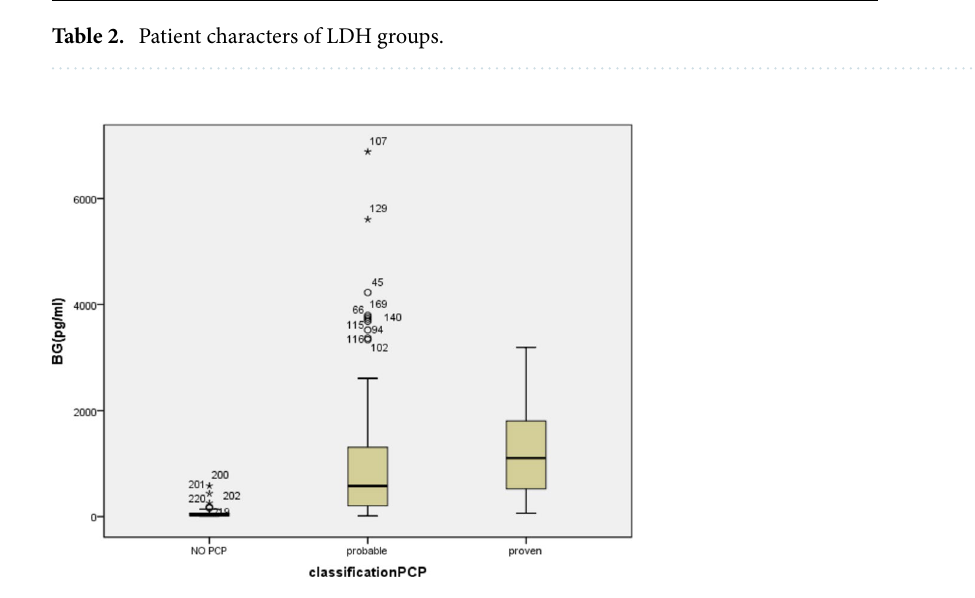
Figure 2. (Box-and-whisker plot): The mean levels of BG in patients with no PCP, probable PCP and proven PCP were 65.03 pg/mL, 983.22 pg/mL, and 1220.09 pg/mL, respectively. The medians of the 3 groups were 27.95 (14.60, 65.00) pg/mL, 580.0(206.0, 1311.0) pg/mL,1107.0 (524.1, 1806.0) pg/mL respectively.